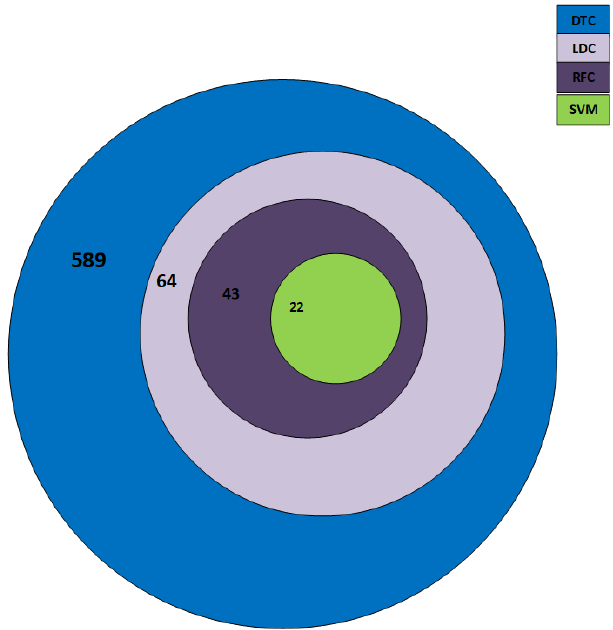
Figure 3. Intersection of features corresponding to classifiers.